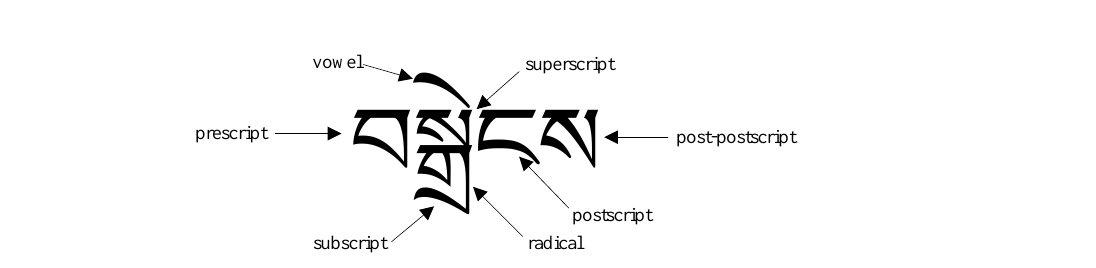
Figure 1. The typical longest Tibetan character. The spelling order of a Tibetan character is prescript, superscript, radical, subscript, vowel, postscript, and post-postscript. A Tibetan character has at least one